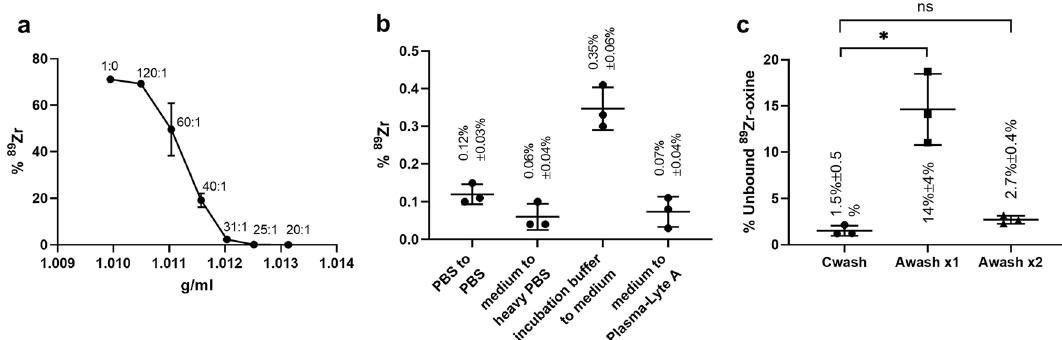
Figure 3. Laminar flow mixing data plots. ( a ) The % 89 Zr measured in the sample outlet, compared to the activity added in the culture medium in the sample inlet, as a function of various heavy PBS (HPBS) densities used in the media inlet (n = 3, mean ± SD). ( b ) % 89 Zr measured in the sample outlet for all the acoustophoresis washing steps and also PBS to PBS cell transfer to determine the level of laminar flow mixing using the same density solutions (n = 3, mean ± SD). ( c ) Plots of the % unbound 89 Zr-oxine remaining in the cell suspension compared to the activity added for incubation, after the complete centrifugal labeling procedure (Cwash) and after one and two wash cycles post-incubation in the acoustophoresis labeling procedure (Awash) (n = 3, mean ± SD, * P < 0.05, ns: not significant).